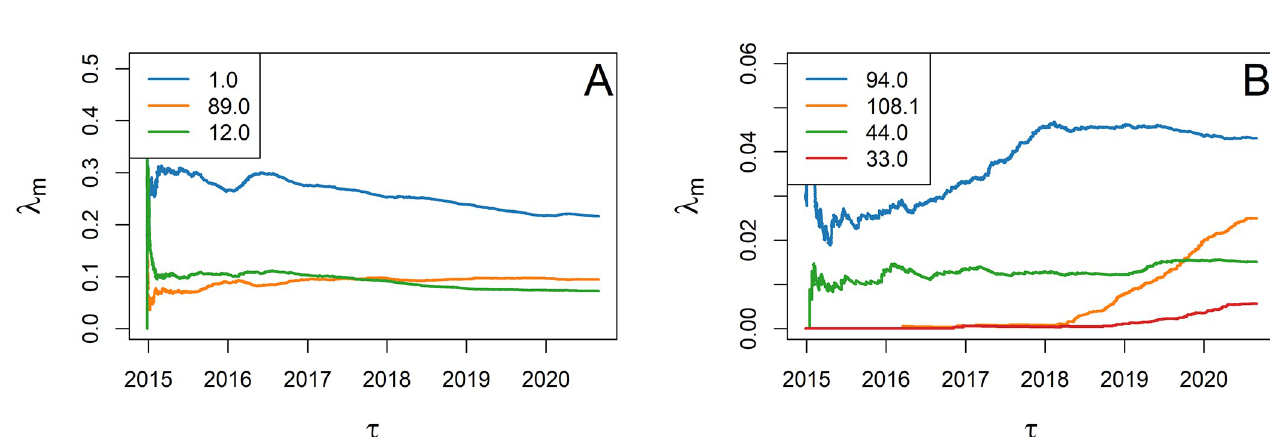
PLOS Computational Biology | https://doi.org/10.1371/journal.pcbi.1010726 November 30,